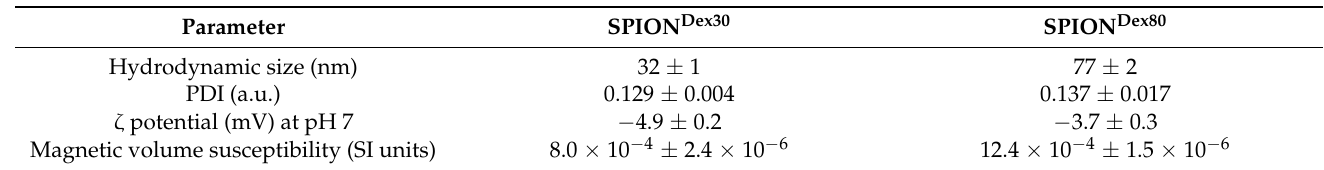
Table 1. Comparison of basic physicochemical parameters of SPION Dex with a mean size of 30 and 80 nm, respectively.